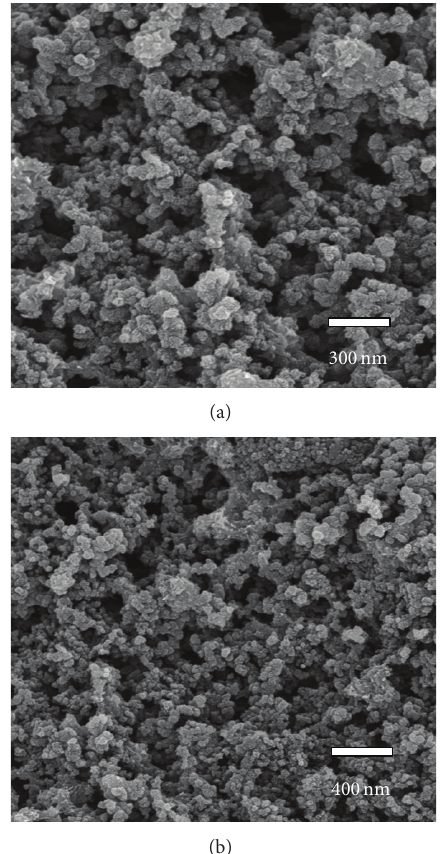
Figure 2: SEM images of (a) pure SnO 2 and (b) NiO/SnO 2 compos- ites.